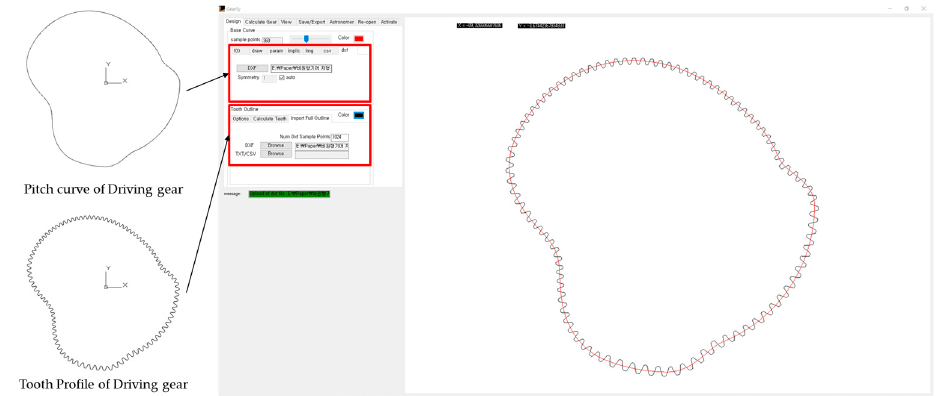
Figure 9. Insertion of design information for driving gear.